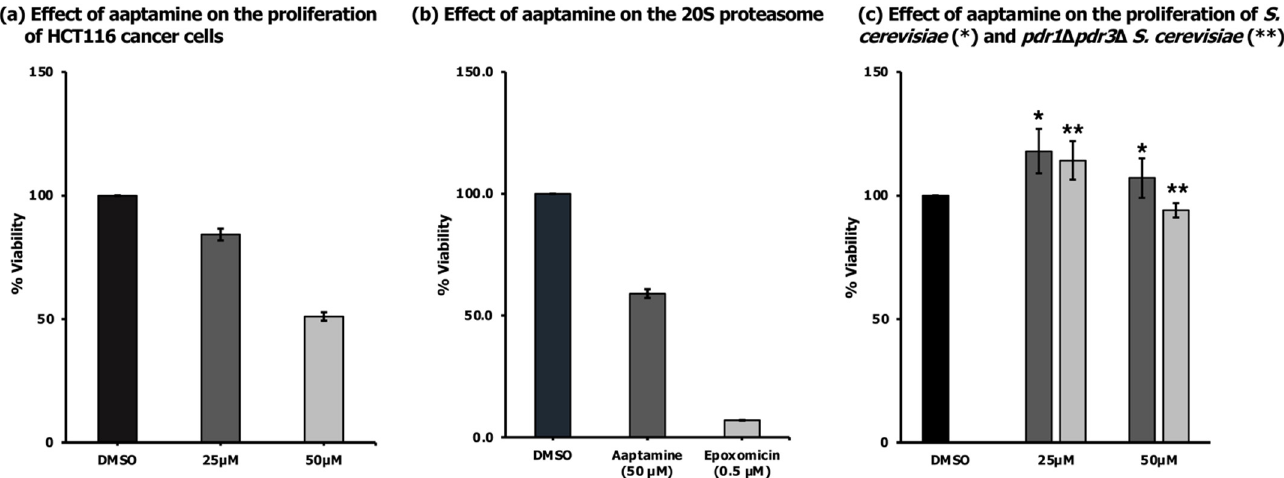
Figure 2. Activity of aaptamine on cancer cell viability, a potentially functionally related target (proteasome), and yeast cell viability. ( a ) Effect of aaptamine on the proliferation of HCT116 cancer cells. HCT116 cells were incubated for 48 h in the presence of different concentrations of aaptamine and the effects were compared to a solvent control (DMSO). ( b ) Effect of aaptamine on the purified 20S proteasome from human erythrocyte using Suc-LLVY-AMC fluorogenic peptide as the substrate. The proteasome and aaptamine (50 µM) were incubated for 10 min to allow inhibitor/enzyme interactions. Epoxomicin (0.5 µM) served as the positive control. ( c ) Effect of aaptamine on the proliferation of S. cerevisiae (*) and pdr1 ∆ pdr3 ∆ S. cerevisiae (**). The strain was incubated for 24 h in the presence of different concentrations of aaptamine and the effects were compared to the solvent control (DMSO). Data are presented as mean ± SD (n = 3), relative to 0.5% DMSO treatment + vehicle.